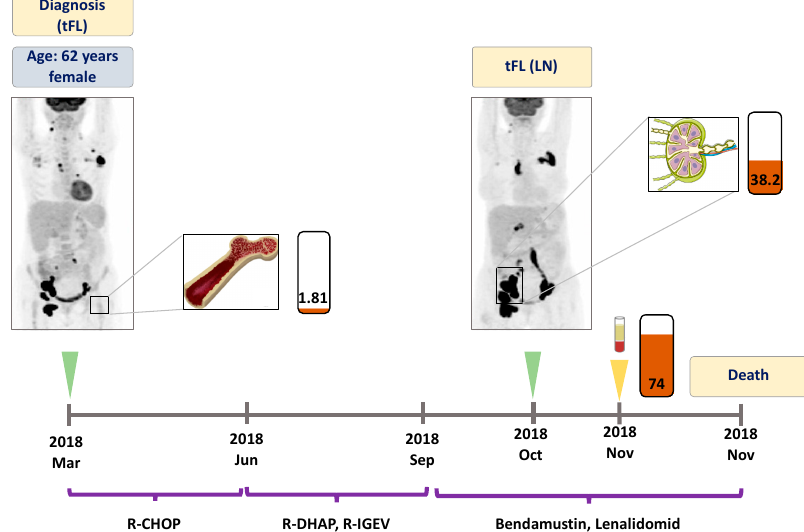
Figure 3. Detailed illustration of treatment monitoring in Patient #3. Liquid biopsy obtained one week prior to the death of the patient revealed high allele frequency of EZH2 A682G mutation. Numbers in the rectangles represent the VAF of the mutation, brown color indicates the A682G variant. Green arrows indicate the time when the PET scans were performed, the yellow arrow indicates the time when liquid biopsy specimens were collected. LN: lymph node, BM: bone marrow, tFL: transformed follicular lymphoma. R-CHOP: rituximab, cyclophosphamide, doxorubicin, vincristine, prednisone. R-DHAP: rituximab, dexamethasone, high-dose cytarabine, cisplatin. R-IGEV: rituximab, ifosfamide,